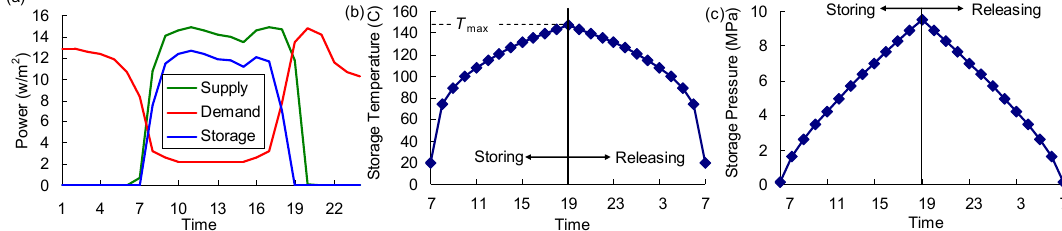
Figure 4. Daily energy storage cycle for 2-story, 7 × 7 m column spacing, d i = 200 mm: ( a ) energy available